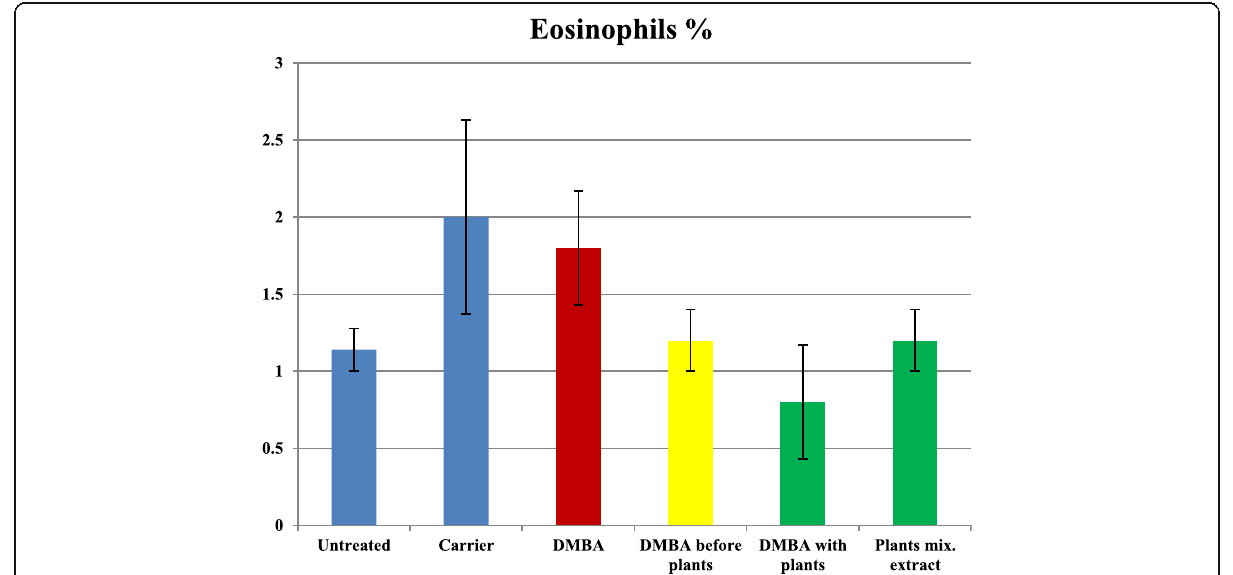
Fig. 7 Eosinophil percentage in the different rat groups. Standard errors are indicated on the bars and the significance levels are shown in Table